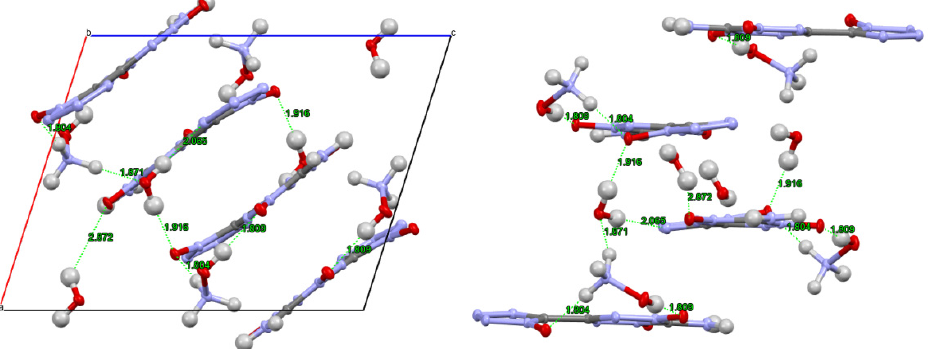
Figure 4. Fragment of infinite H-bonded column in crystal of 11 . The values of the bond lengths are given in angstroms.